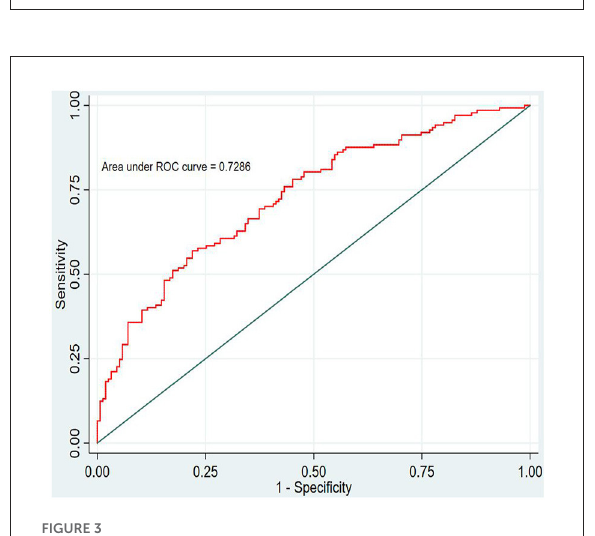
FIGURE3 Internal verification set.